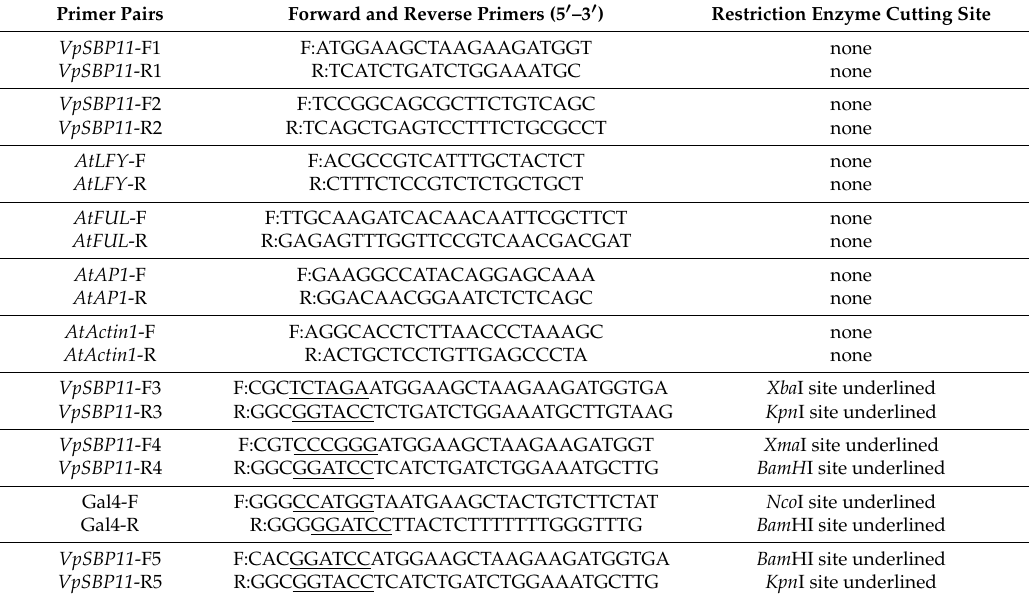
Table 1. The information of primers used in this paper. F indicates forward primer, R indicates reversed primer and the underline indicates restriction